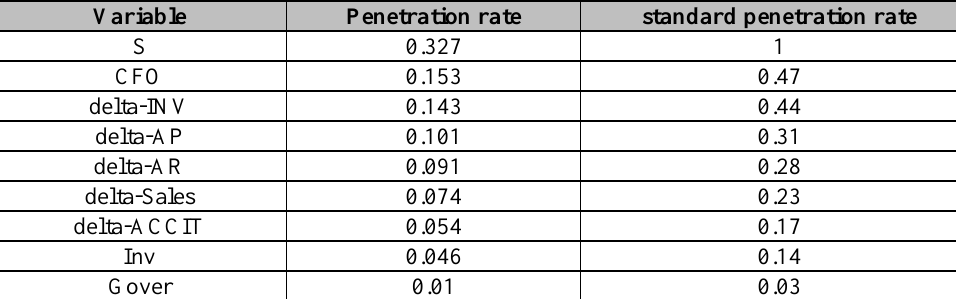
Table 15. Variables effect embellishment on prediction with 11 hidden nodes